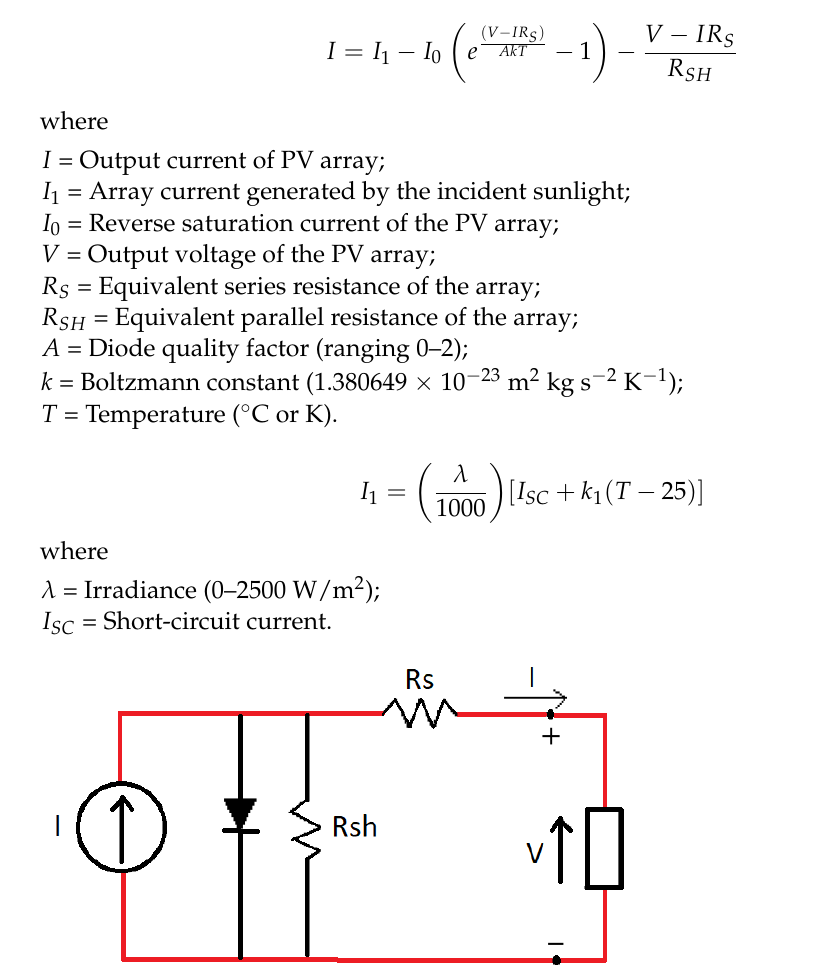
Figure 3. Solar cell equivalent circuit.